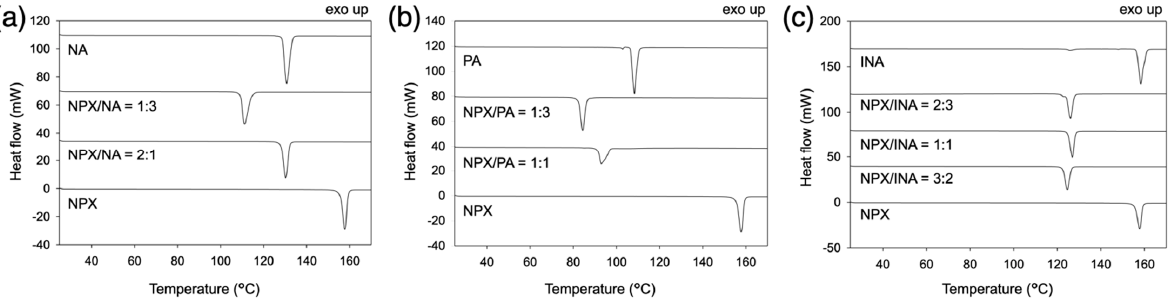
Figure 3. DSC thermograms of some mixtures of ( a ) NPX/NA, ( b ) NPX/PA, and ( c ) NPX/INA.